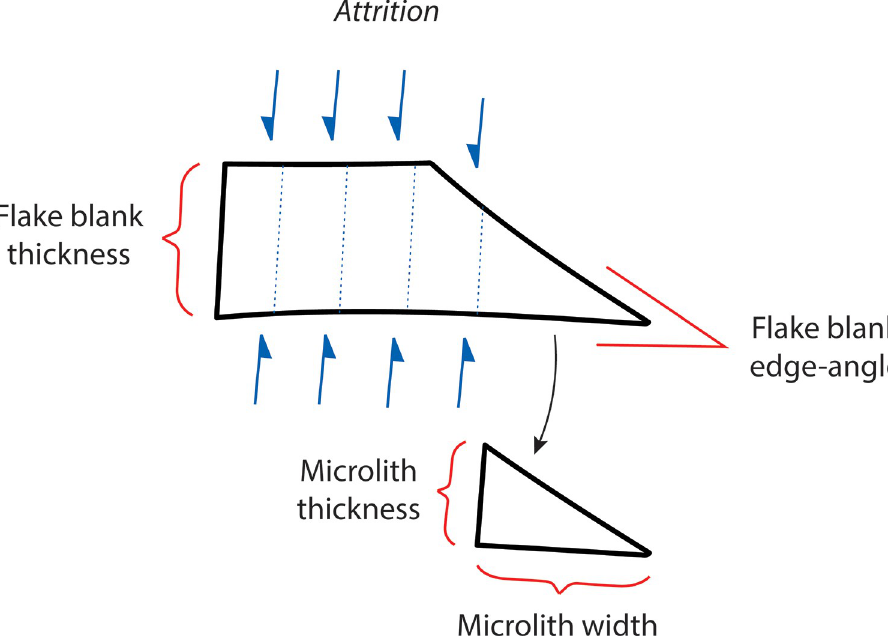
Fig 31. Schematic cross-section of flake attrition and backing, Horizon IV, Saruq al-Hadid. The drawing illustrates how the thickness of a finished microlith may not reflect the thickness of the flake blank. Attrition progresses until the microlith falls within the desired thickness range; the width of the finished microlith will be strongly influenced by the edge-angle of the flake blank.